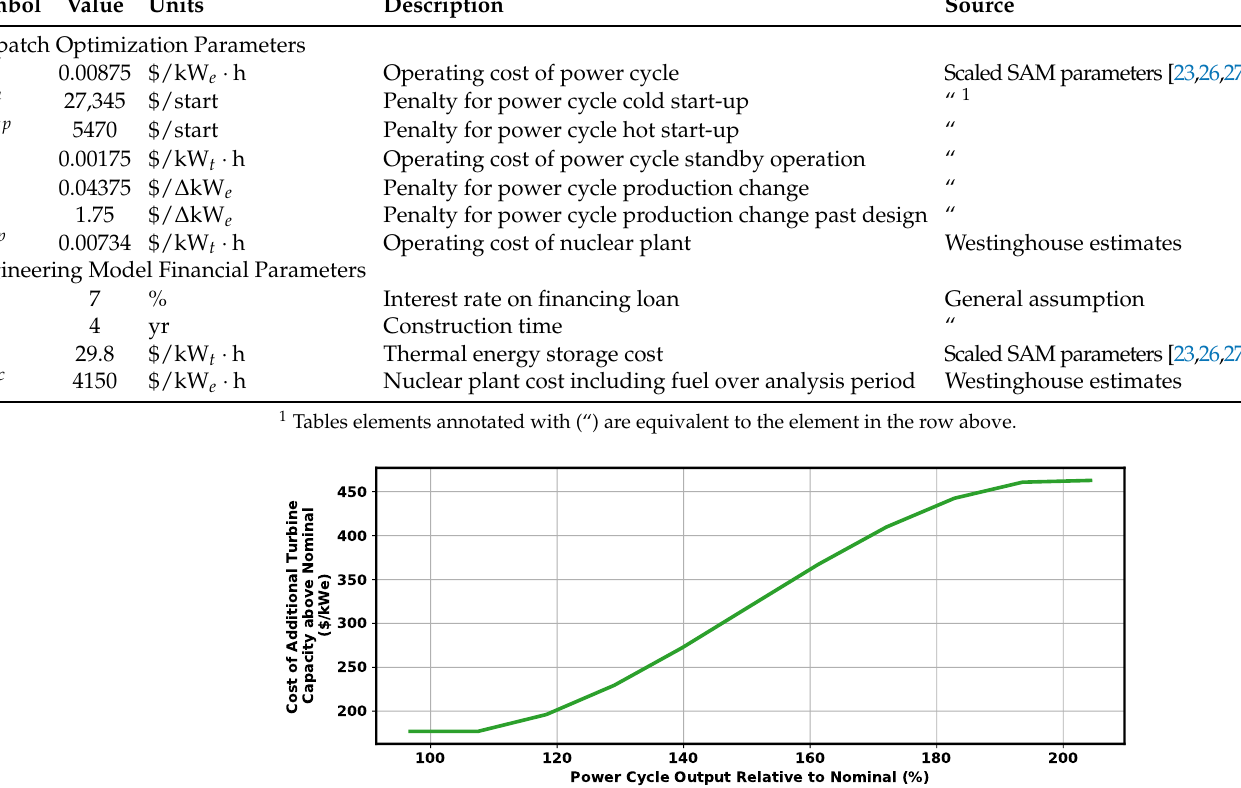
Figure 3. Cost of additional power conversion capacity above nominal